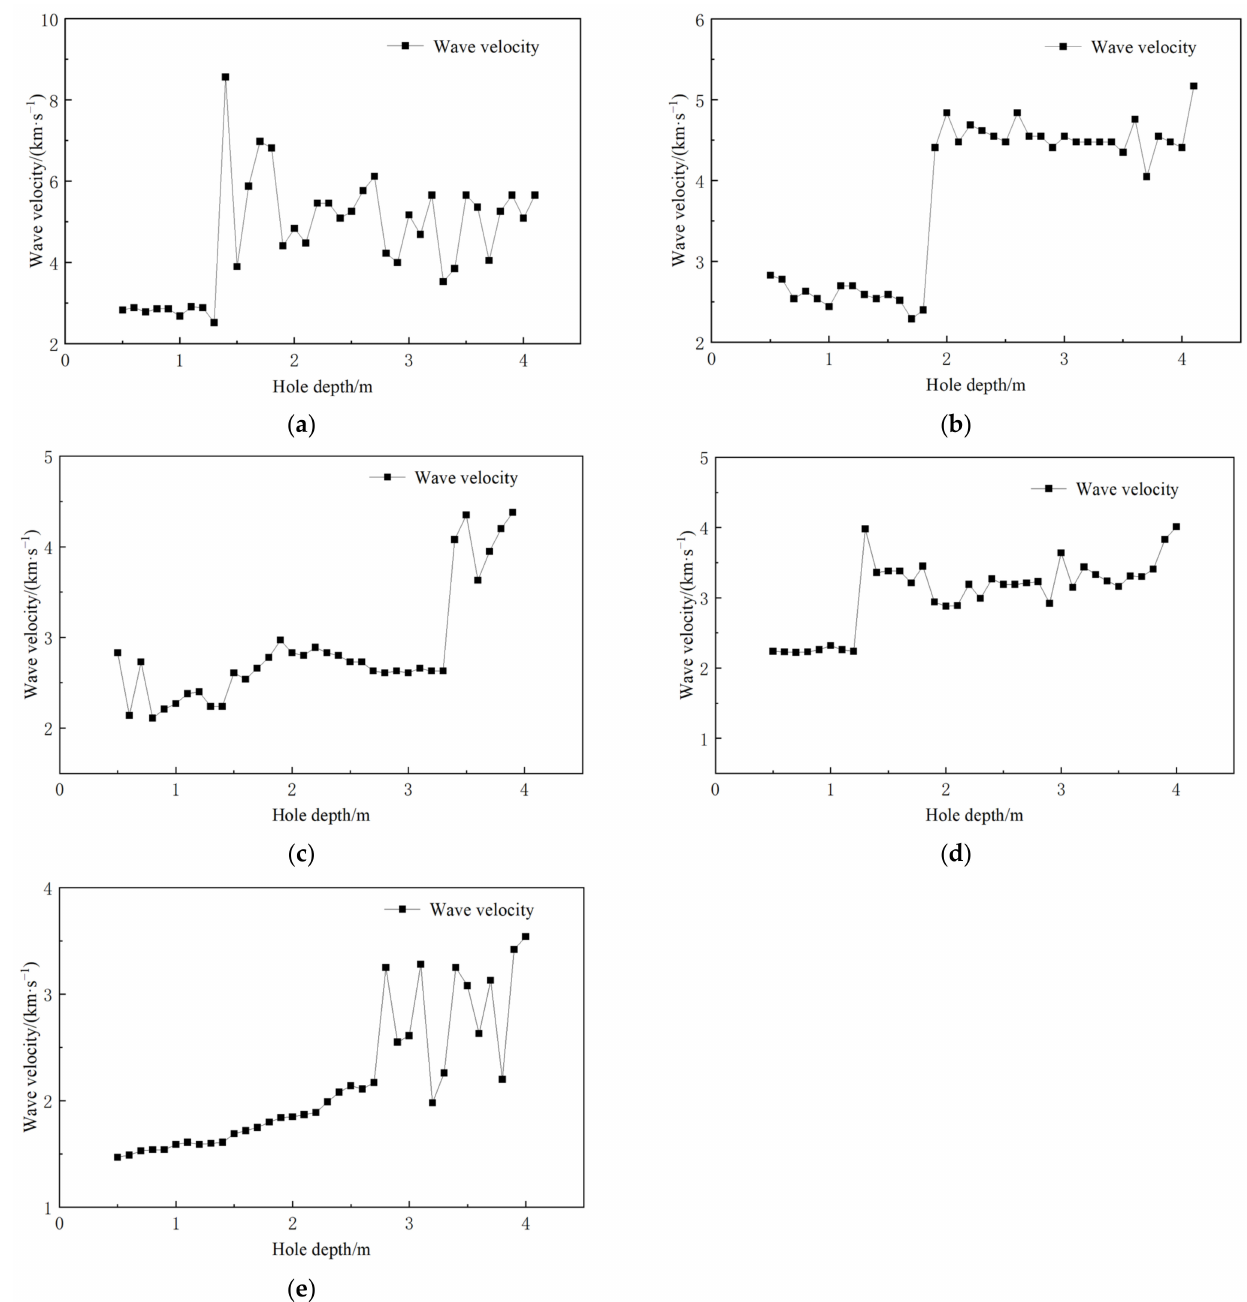
Figure 16. P-wave velocity test curve. ( a ) Hole 1; ( b ) Hole 2; ( c ) Hole 3; ( d ) Hole 4; ( e ) Hole